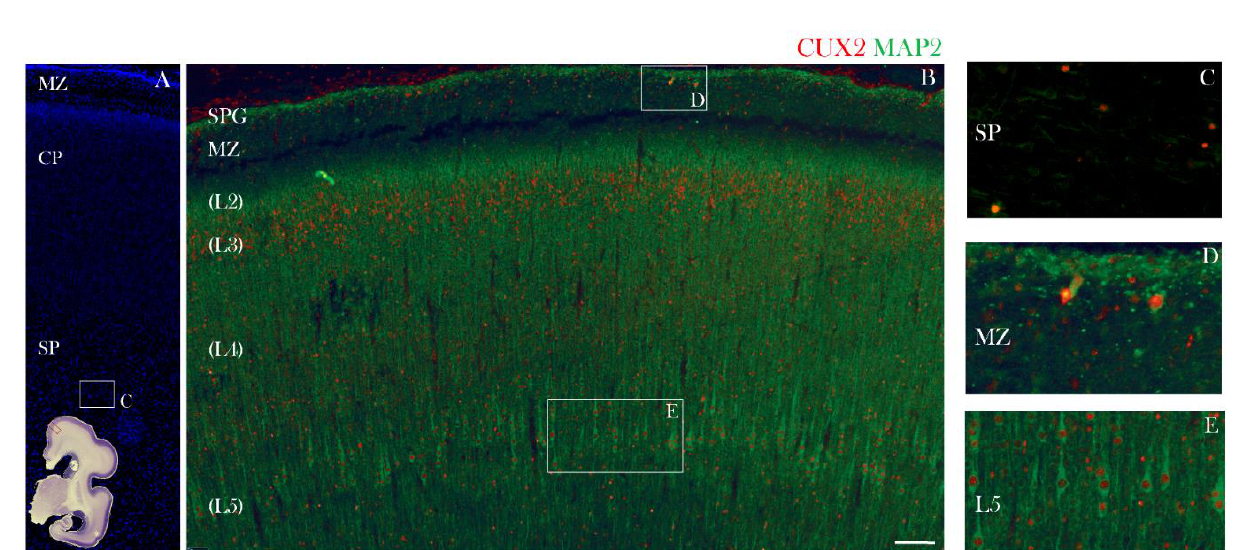
Figure 6. CUX2 is expressed in upper MZ, upper CP, and SP during the peak SP stage at 24 PCW. ( A–E ) Representative images of medial dorsal part of the cerebral cortex in the prospective precentral gyrus indicated by red box on the inset representing complete scan of coronal Nissl section shown in lower left corner of A. ( A–C ) Developing neocortex was immunostained for CUX2 (red), neuronal marker MAP2 (green) and DAPI (blue). During the stationary SP phase at 24 PCW in the prospective precentral gyrus, CUX2 reactivity is most prominent in the upper portion of the CP ( A,B ), and SP ( A,C ). C is higher magnification of box denoted in A above the inset. D and E are higher magnifications of boxes denoted in B, respectively. Strong CUX2+ reactivity in the MZ ( D ) relates to prospective CR cells, while moderate reactivity in the MZ relates to small subpial granular layer (SPG) nuclei. The giant layer 5 pyramidal cells that are MAP2+ show weak CUX2 reactivity ( B,E ). Scale bar = 100 µm.